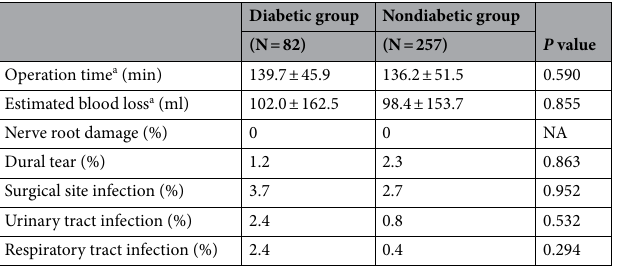
Table 2. Comparison of surgical factors for patients with diabetes and those without diabetes. Other values are given as the percentage in each group. a The values are given as the mean and the standard deviation.